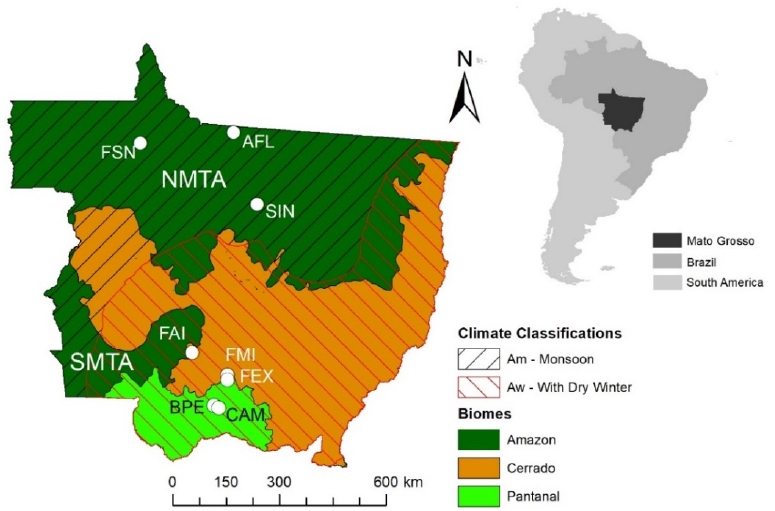
Figure 1. Location of flux towers in the evergreen ombrophilous forest (AFL), Amazon–Cerrado transition tropical forest (SIN), Brachiaria brizantha pasture (FSN) in the Amazon, Stricto Sensu Cerrado (FAI), mixed woodland–grassland (FMI), Brachiaria humidicola pasture (FEX) in the Cerrado, floodplain areas of Cambará monodominant forest (CAM) and shrubs (BPE) in the Pantanal and the Köppen’s climate classification [41] in the State of Mato Grosso, Brazil. The Amazon biome in this study was identified as North Mato Grosso Amazon (NMTA) and South Mato Grosso Amazon (SMTA).